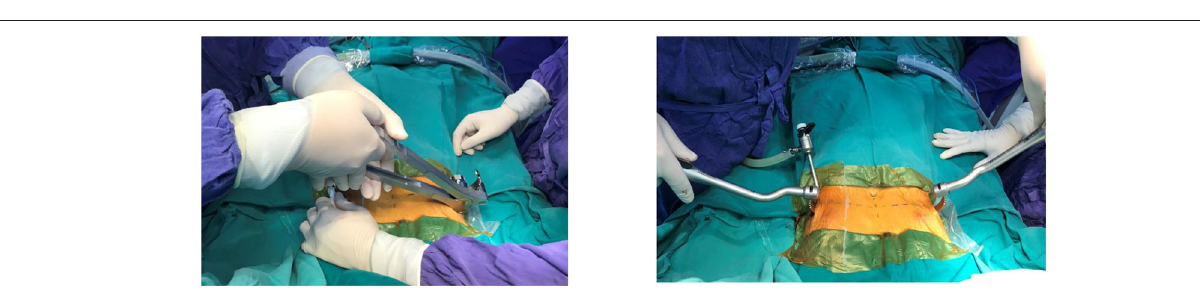
FIGURE 2 | Metal bar was threaded through the left-to-right mediastinum.